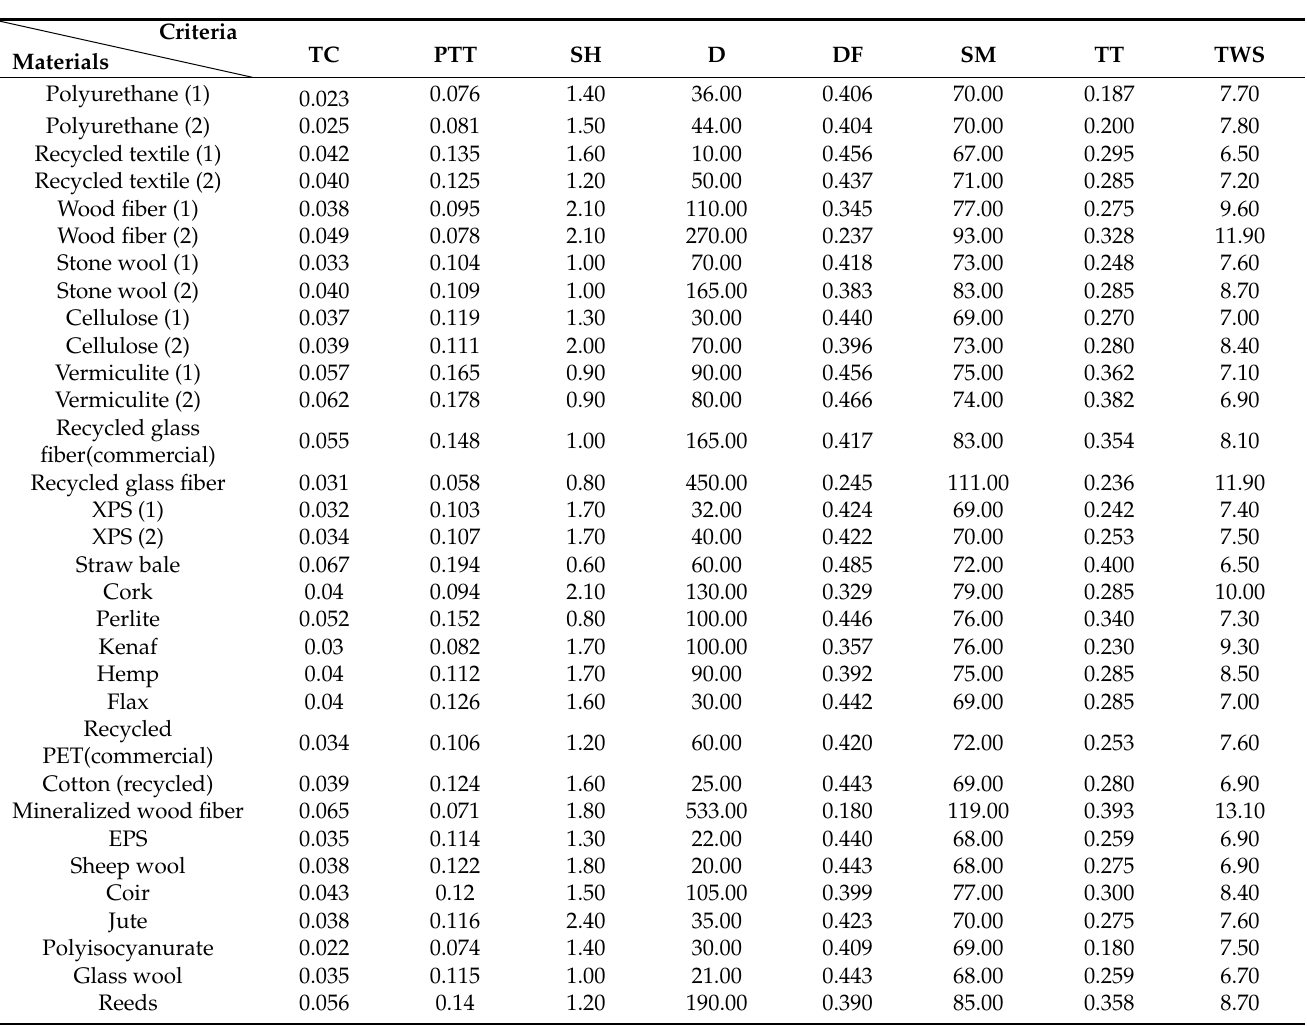
Table 5. Decision Matrix [13].